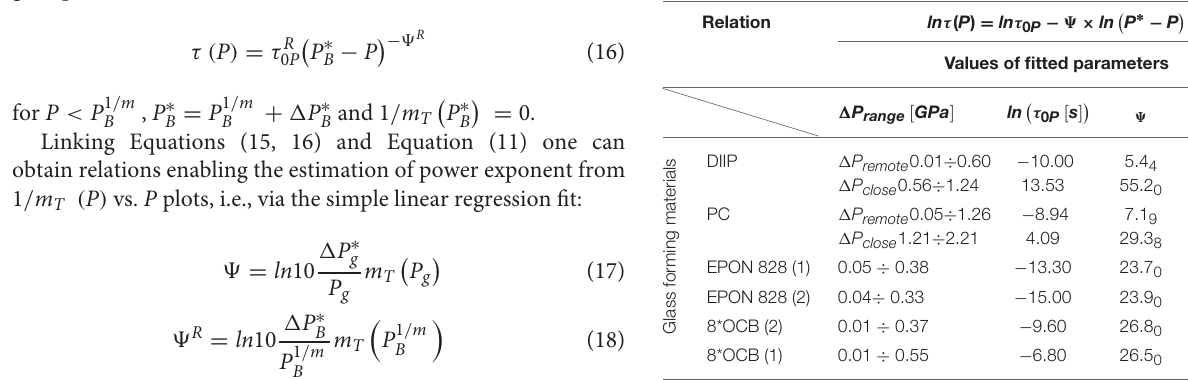
TABLE 2 | Results of fitting of experimental data